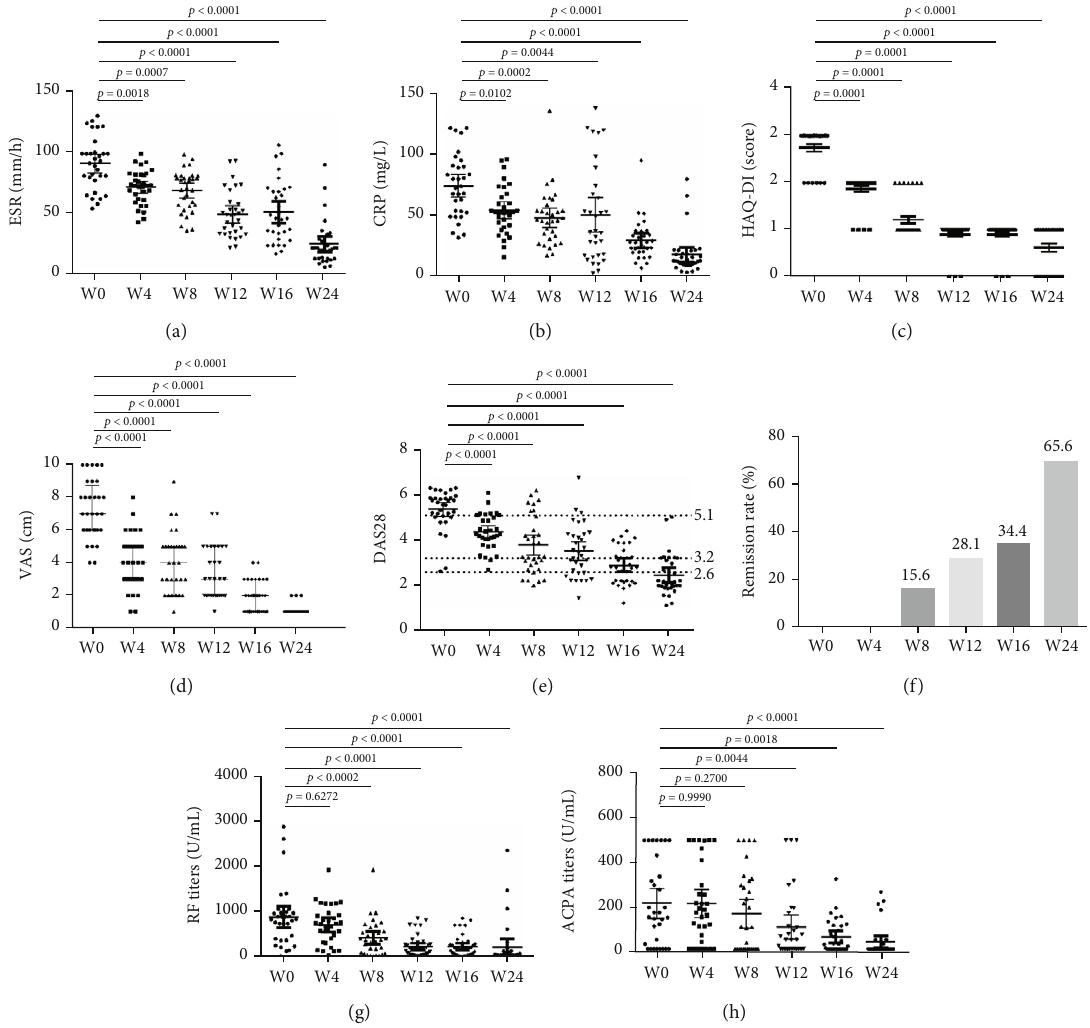
Figure 1: Changes in ESR (a), CRP (b), HAQ-DI (c), VAS (d), DAS28 (e), RF (g), and ACPA (h) in patients treated with tofacitinib. In (f), the dotted horizontal lines indicate borders between categories of DAS28: (i) high ( DAS28 > 5 : 1 ); (ii) moderate ( 3 : 2 < DAS28 ≤ 5 : 1 ); (iii) low ( 2 : 6 ≤ DAS28 ≤ 3 : 2 ); and (iv) patients in remission ( DAS28 < 2 : 6 ). The x -axis has six measurement time points indicated as 0, 4, 8, 12, 16, and 24 weeks after tofacitinib treatment. Abbreviations: ESR: erythrocyte sedimentation rate; CRP: C-reaction protein; HAQ-DI: Health Assessment Questionnaire-Disability Index; VAS: visual analogue scale; DAS28: disease activity score in 28 joints based on erythrocyte sedimentation rate; RF: rheumatoid factor; ACPAs: anticyclic citrullinated peptide